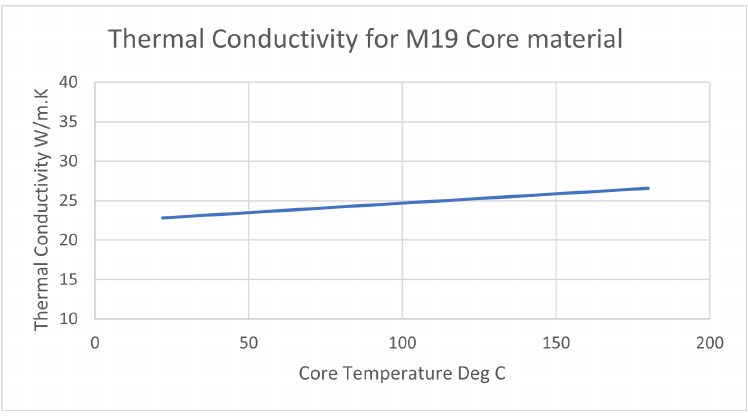
Figure 12. Thermal conductivity of M19 core